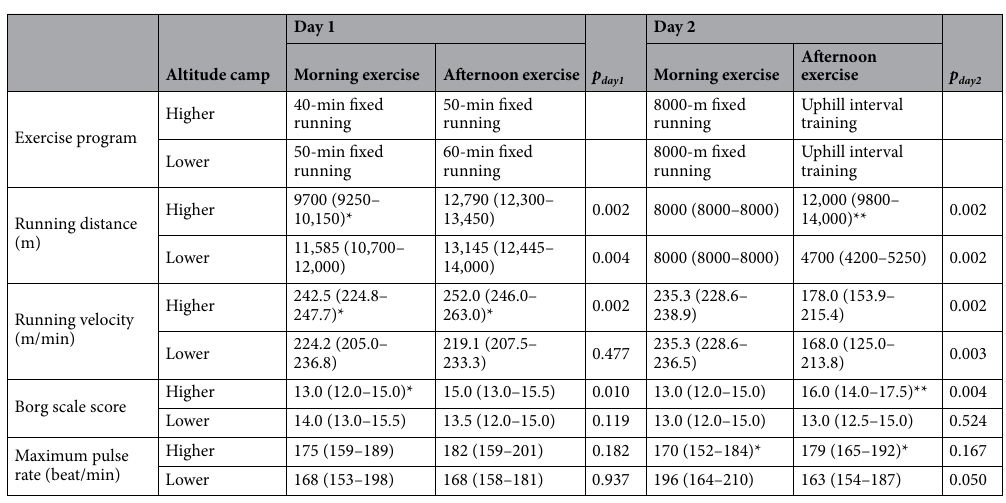
Table 2. Running intensities of the exercise programs performed by female long-distance runners during the two camps. Data are expressed as median (25th–75th percentile). * p < 0.05 and ** p < 0.01 comparing variables between the higher- and lower-altitude camps using the Wilcoxon signed-rank test. p day1 morning exercise vs. afternoon exercise on day 1 using the Wilcoxon signed-rank test. p day2 morning exercise vs. afternoon exercise on day 2 using the Wilcoxon signed-rank